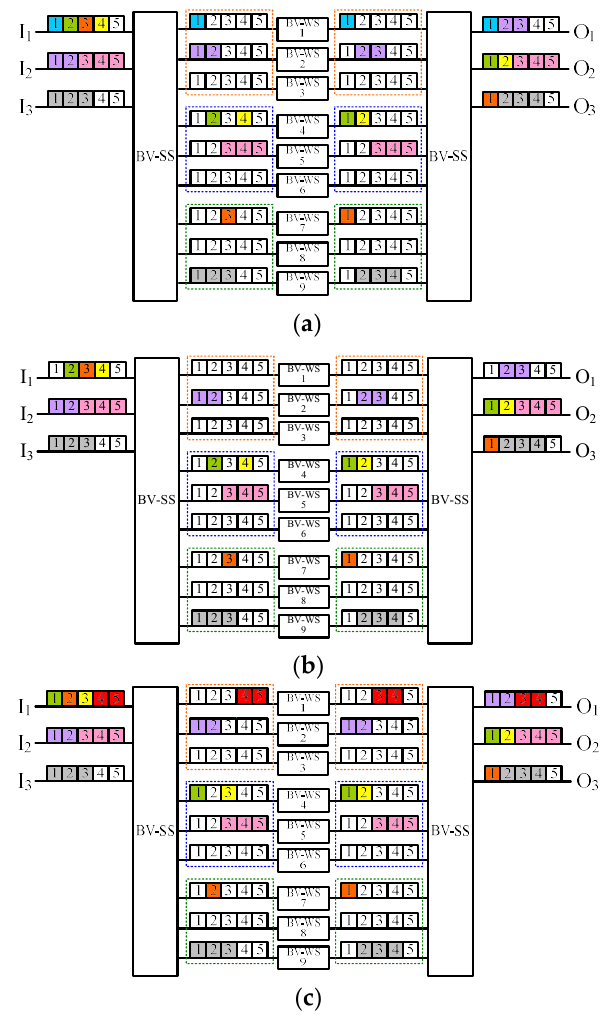
Figure 3. Suppose connections (1, 1, 1), (1, 2, 1), (1, 3, 1), (1, 2, 1), (2, 1, 2), (2, 2, 3), and (3, 3, 3) arrive sequentially in an SWS1(3, 9, 5) switching fabric. Note each dashed box is a group of internal links. ( a ) These connections are routed by Routing Algorithm 2 (for Arrivals). ( b ) Suppose connection (1, 1, 1) departs, and (1, 1, 2) arrives. Then, connection (1, 1, 2) is blocked. ( c ) Connections marked in green, orange, yellow, and purple are rearranged according to Routing Algorithm 2 (for Rearrangements), and (1, 1, 2) can be routed in the SWS1(3, 9, 5) switching fabric.